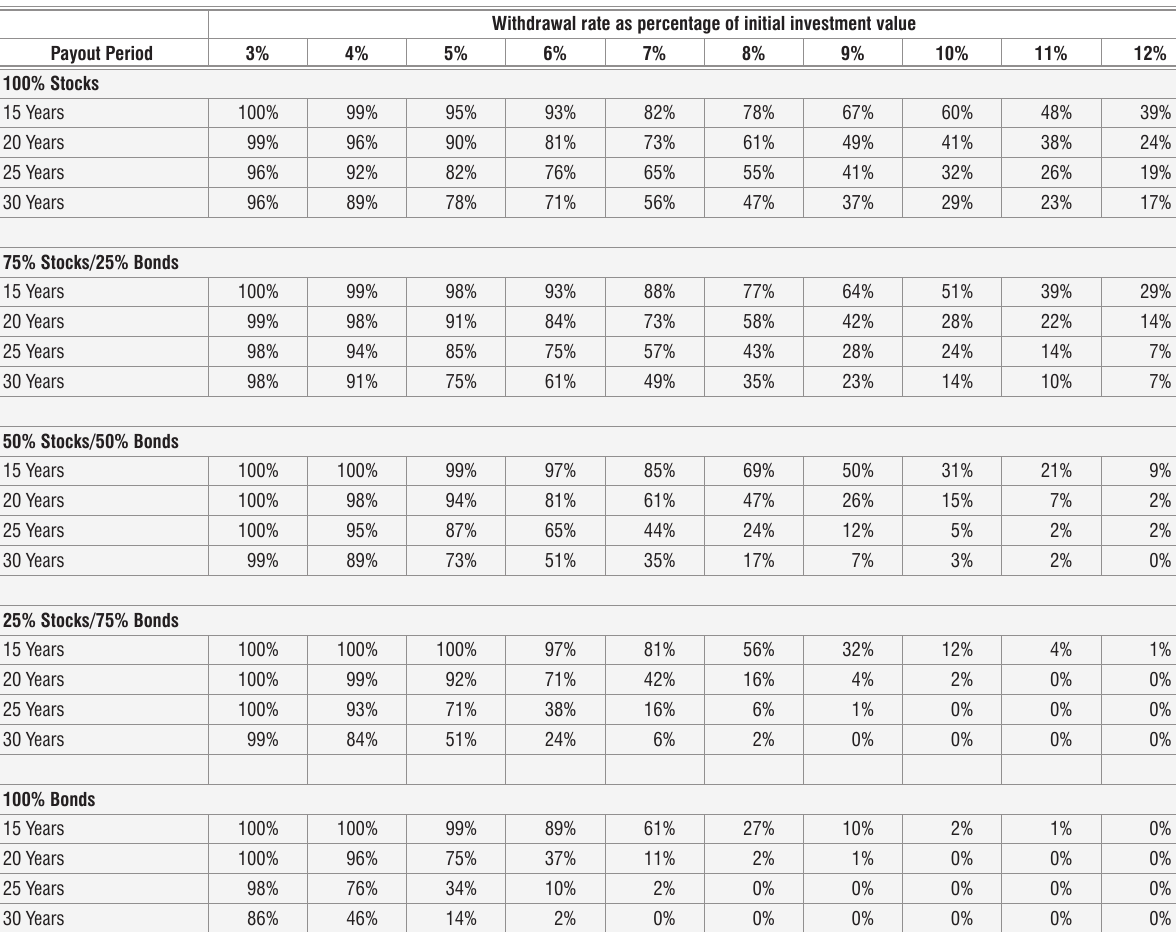
Portfolio success rate for different asset allocation and withdrawal